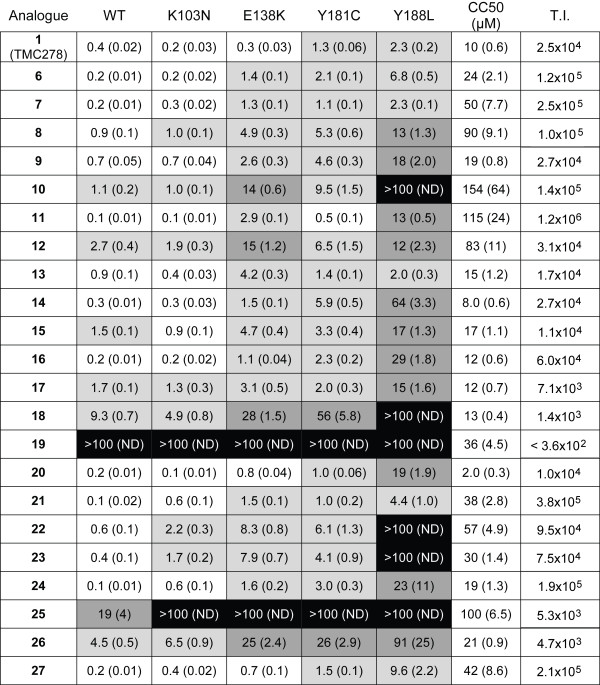
Activities and cytotoxicities of rilpivirine (1) and its analogues. EC50s, as measured by reduction of luciferase reporter activity, are reported as nM values, CC50s are reported as μM values. Standard deviations are indicated in parentheses. Shading of EC50 values indicates a log scale: no shading = EC50 <1.0 nM, light gray = EC50 between 1.0 nM and 9.9 nM, dark gray = EC50 between 10 nM and 99nM, black = EC50 ≥100 nM. Therapeutic Index (T.I.) is the ratio of CC50/EC50.